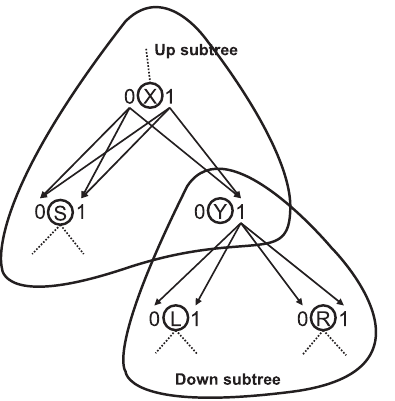
Figure 2. The Up-Down algorithm. Partitioning of a tree relative to state 1 at the node Y is shown by dashed